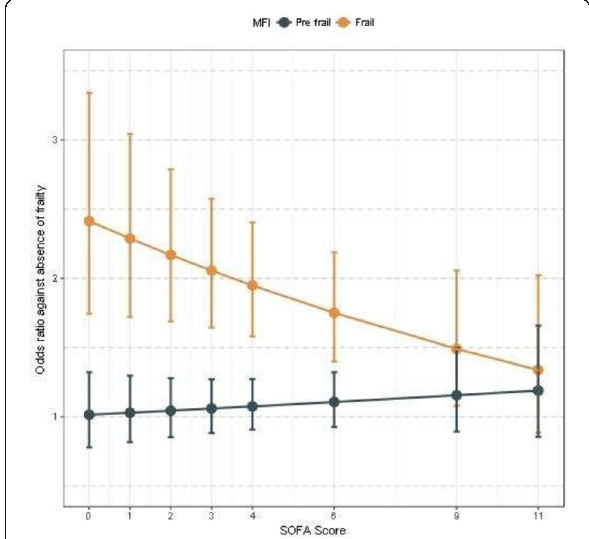
Fig. 1 (abstract 0039). Odds ratio for frailty and pre-frailty at increasing admission SOFA